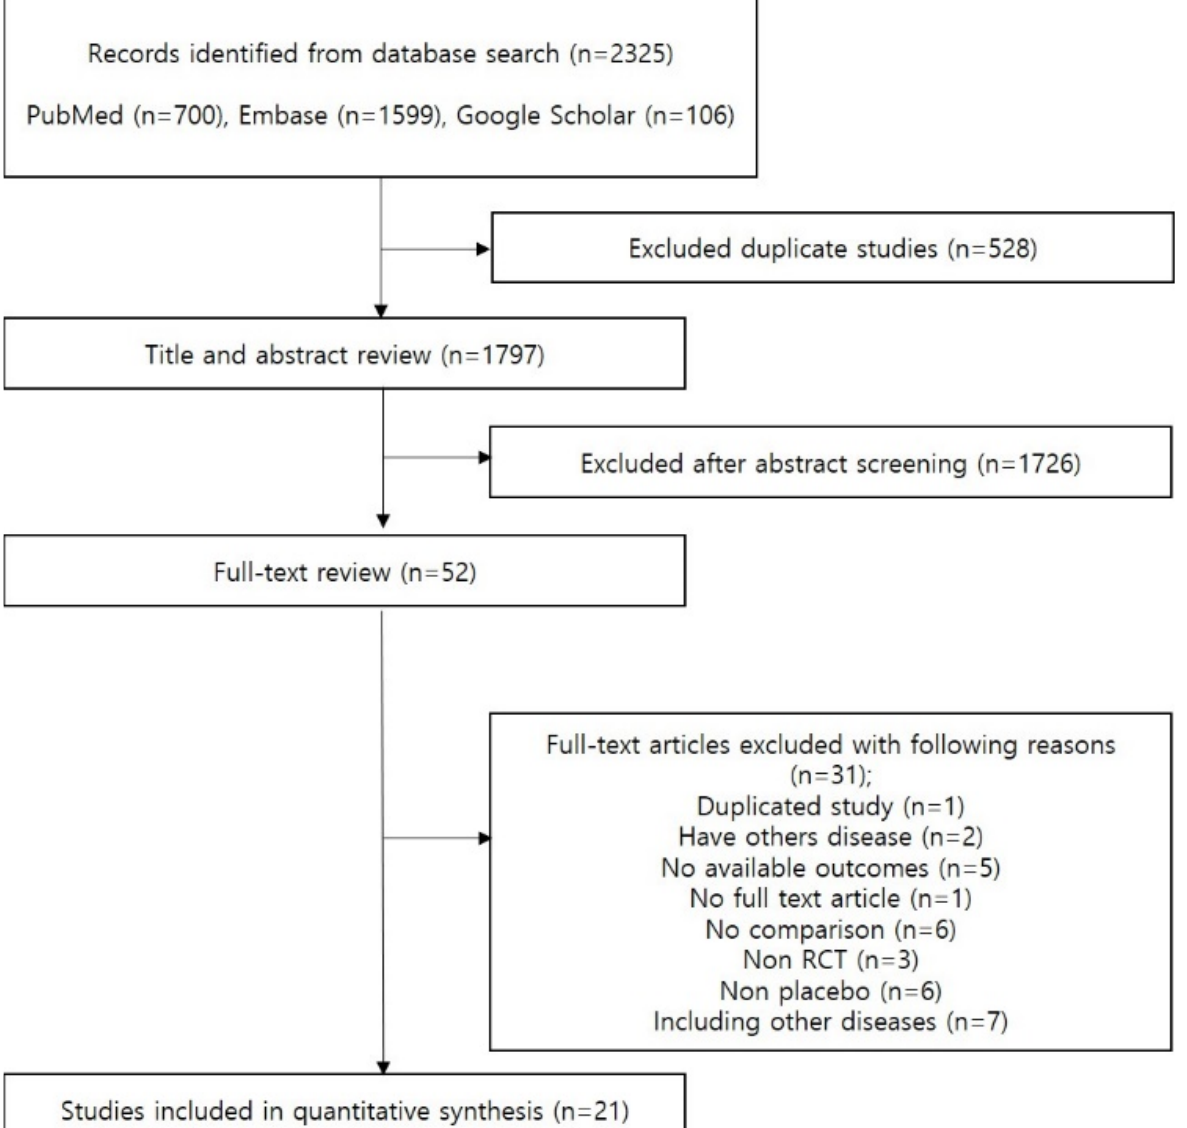
Figure 1. PRISMA Plot.